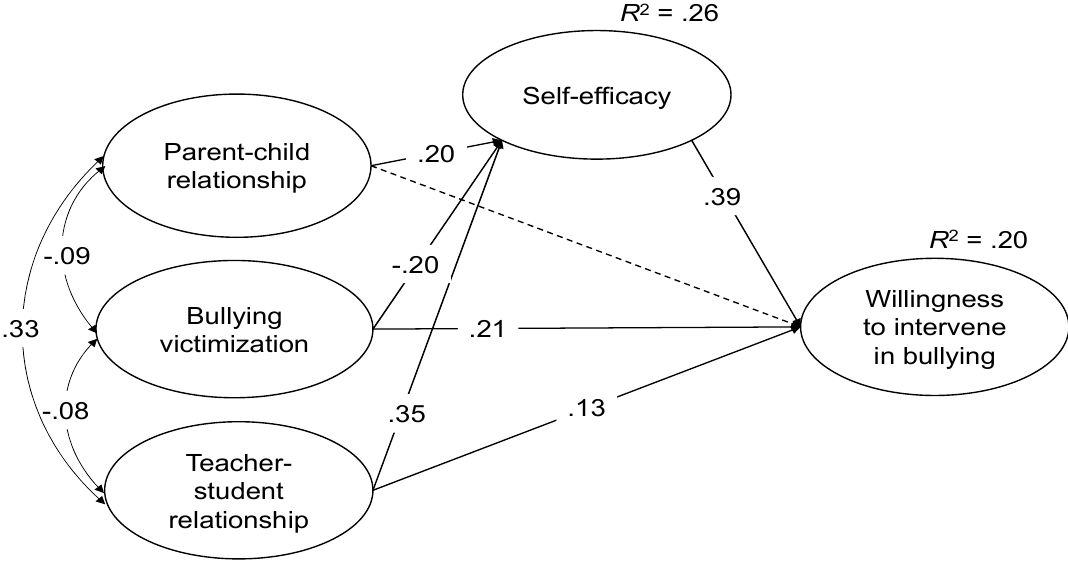
Figure 1. Standardized estimates of relationships between the latent variables, namely parent–child relationship, bullying victimization, teacher–student relationship, self-efficacy, and willingness to intervene in bullying. Notes: Dash arrows: non-significant path coefficient.